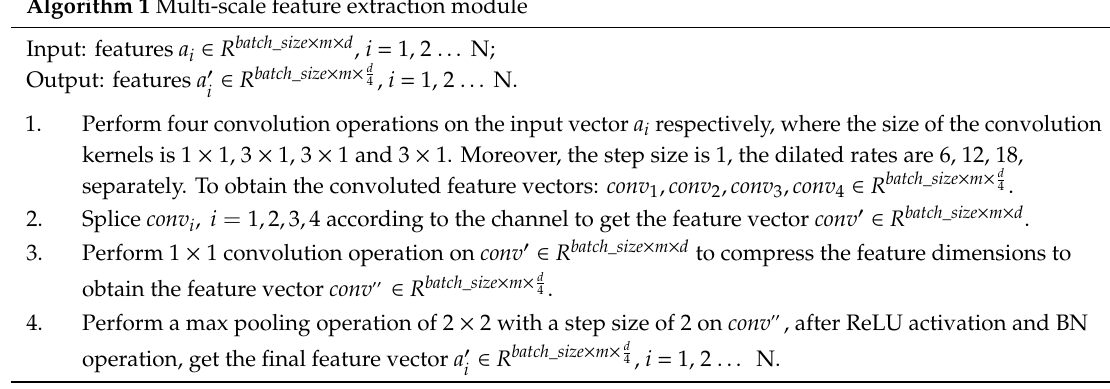
Algorithm 1 Multi-scale feature extraction module